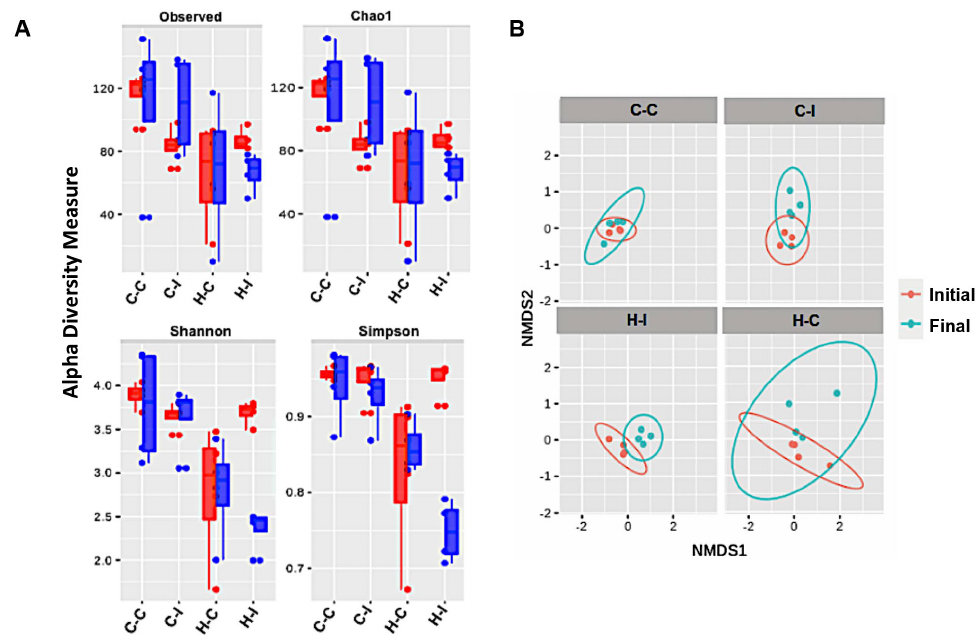
Figure 3. Inulin treatment modifies gut bacterial communities in mice subject to inulin supplementation. ( A ) Alpha diversity measures of cellulose control (C-C and H-C) or inulin supplemented (C-I and H-I) mice groups. The species enrichment is showed at the beginning (red boxes) and at the end of the supplement treatment (blue boxes). ( B ) Gut microbial non-metric multidimensional scale similarity plots indicating the differences among the four mice groups at the initial and final period of the experimental interventions.